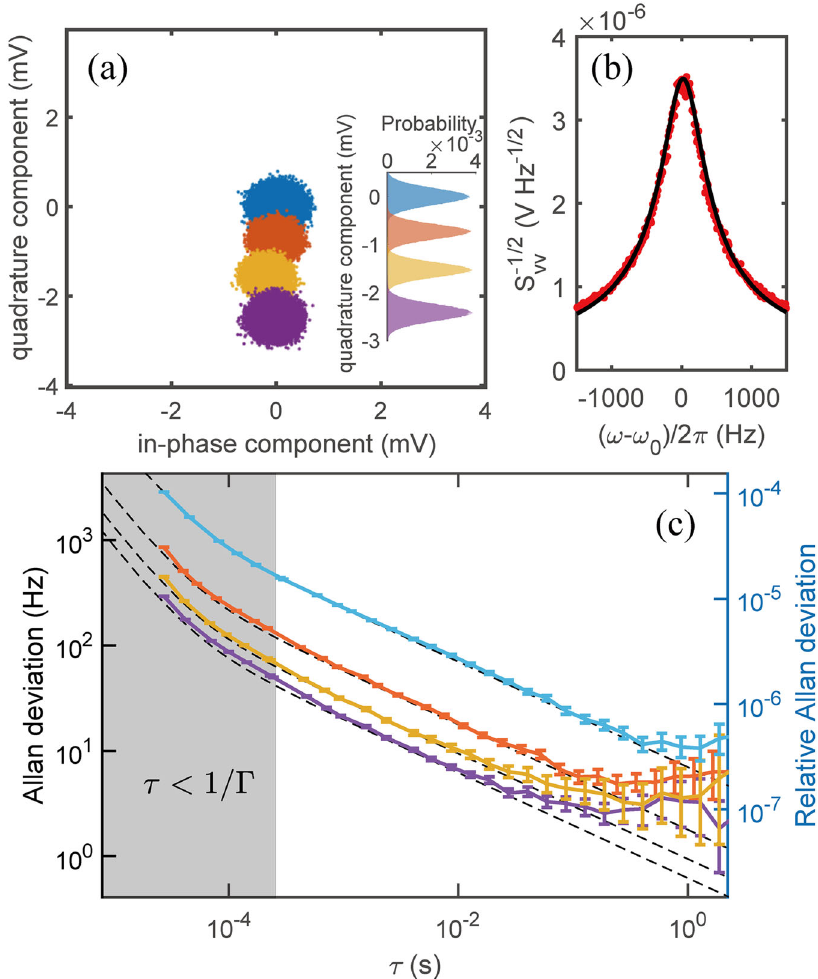
Fig. 4 Experimental data. a Thermal fl uctuation of the nanomechanical resonator in the phase diagram. Different colors correspond to different driving forces (0 V, 0.5 V, 1 V, and 1.5 V). The driving/reference frequency is set near the resonance frequency. The inset shows the distribution density of the quadrature component. b Mechanical vibration power spectral density in vacuum. The black line indicates the Lorentzian fi t. c Allan deviation (ADEV) of the frequency from the experimental data without drive (light blue) and with increasing driving forces (from top to bottom). The ADEVs are from the data sets of the corresponding colors in ( a ). Dashed lines are the corresponding Cramer Rao lower bound. The deviation at τ > 0.1 s is due to bias drift. The marked experimental statistical uncertainties are one standard